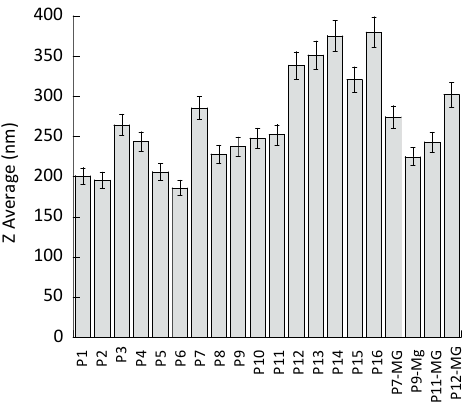
Figure 1. Mean diameter of the indicated formulations. Diameters were measured by PCS and expressed as Z average (nm). Data are the mean of three determinations on different samples ± s.d.